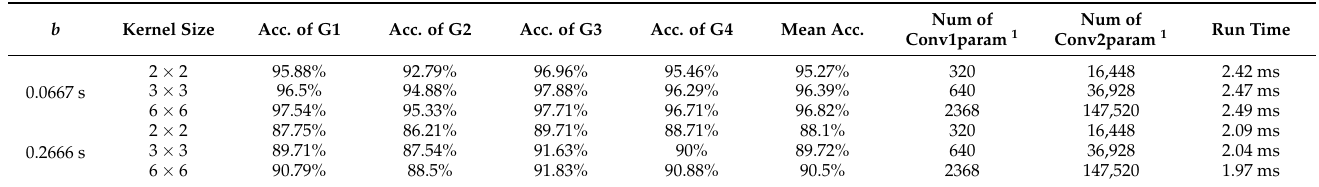
Table 9. Prediction accuracy of DCNN–SVM for CLC with different convolution kernels in Case